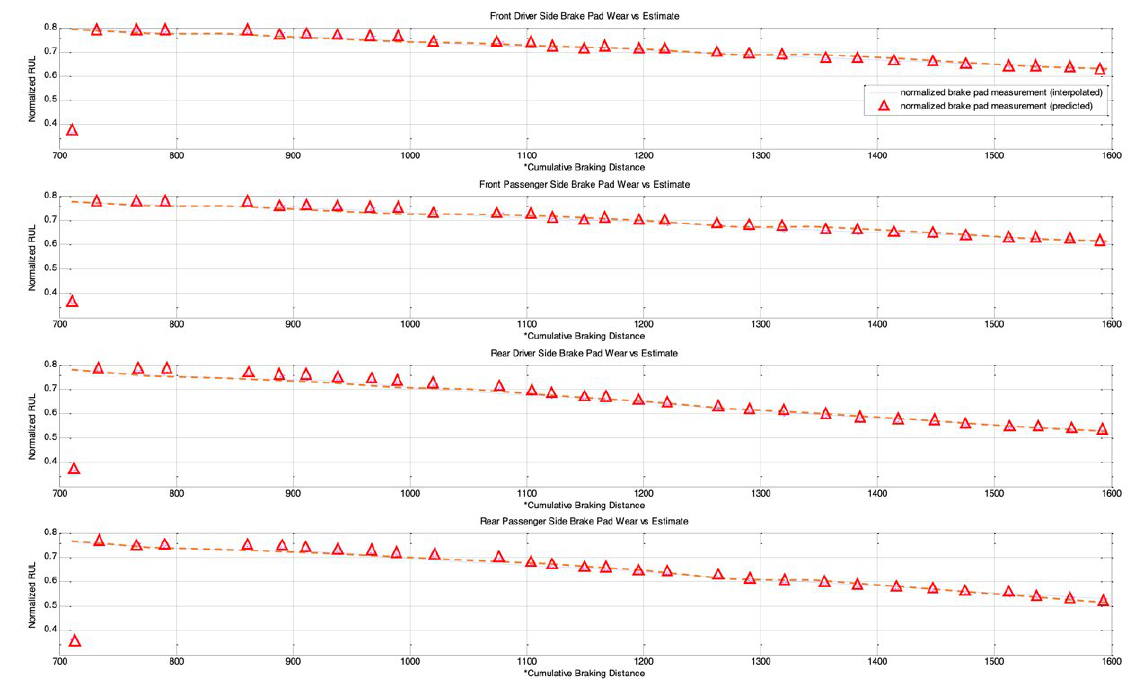
Figure 19. Driver #1, inferred normalized brake wear (dashed-line) vs. predicted brake wear (triangle). Top–bottom shows front driver side, front passenger side, rear driver side, and rear passenger side.